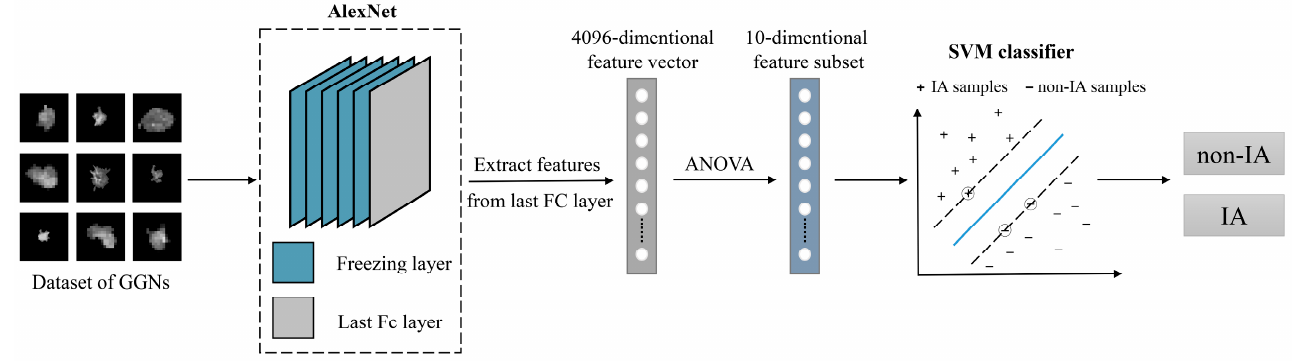
Figure 2. Schematic diagram for classifying IA and non-IA based on SVM and GGNs.